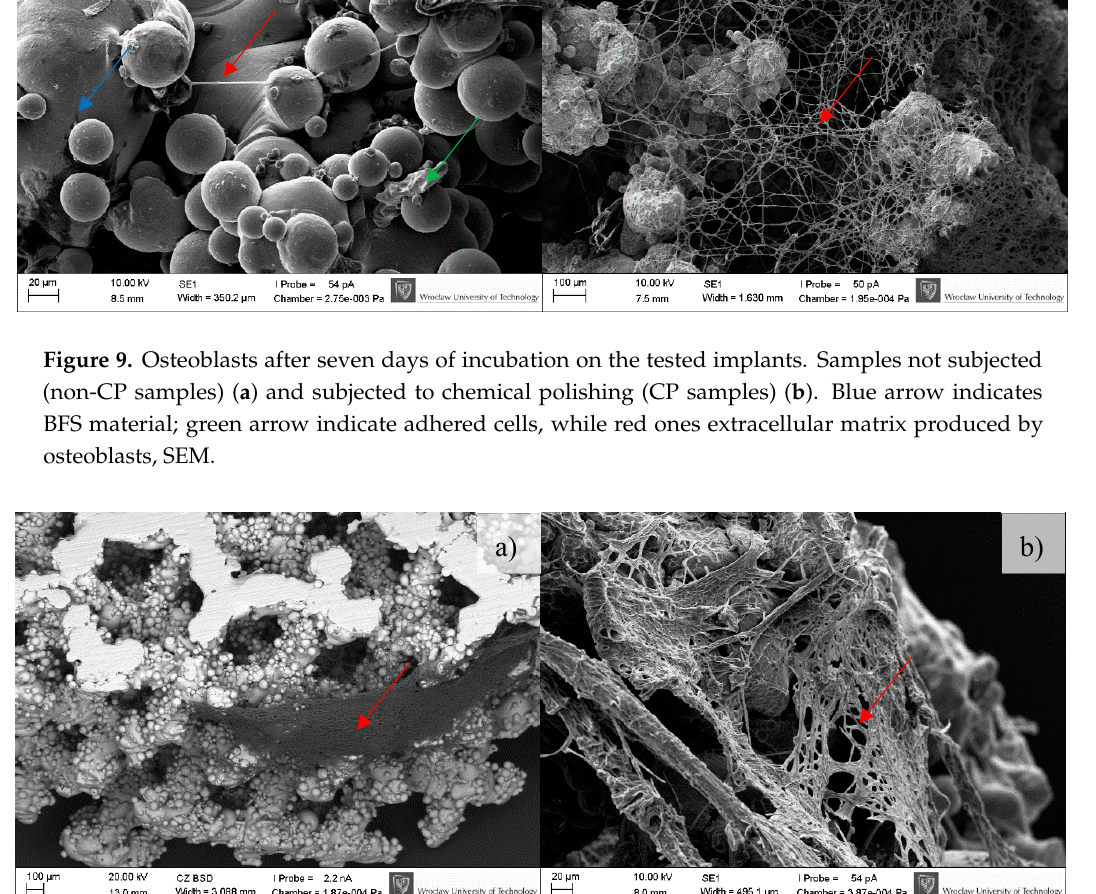
Figure 10. Osteoblasts after 14 days of incubation on tested implants. Samples non-subjected (non-CP samples) ( a ) and subjected to chemical polishing (CP samples) ( b ). Red arrows indicate increasing (please compare it to Figure 9) amount of extracellular matrix produced by osteoblasts, SEM.